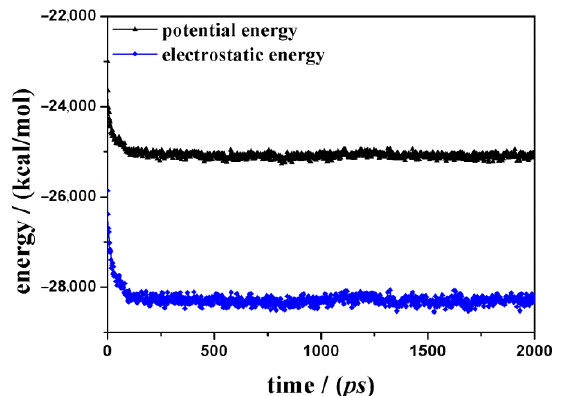
Figure 2. Potential energy (line and symbols in black) and electrostatic energy (line and symbols in blue) calculated as a function of the MD run time starting from 14 ketoprofen drug molecules in racemic mixture on hydrated amorphous SiO 2 surface are shown.